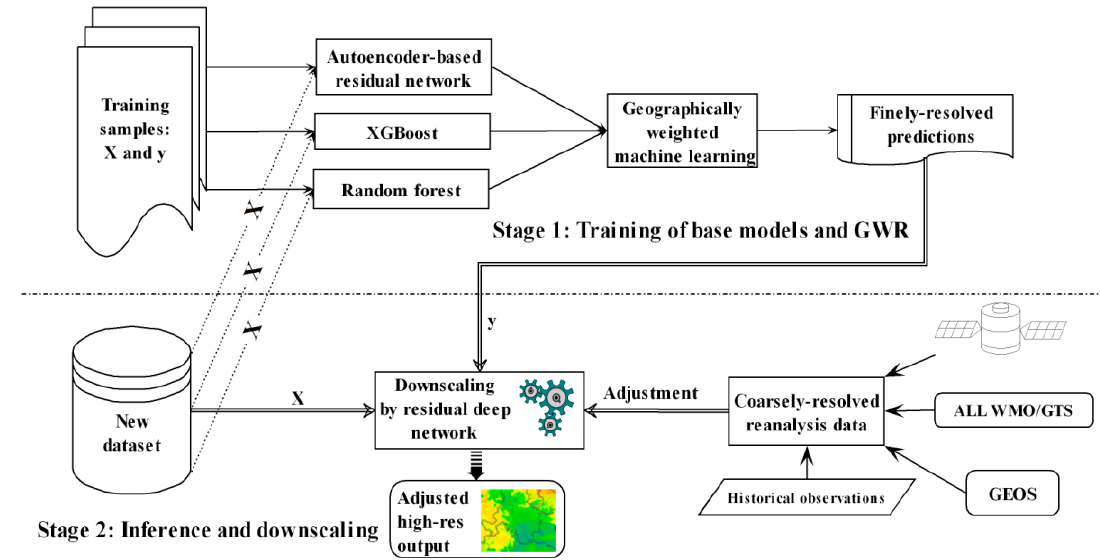
Figure 2. Systematic framework: training of base models and geographically weighted regression (GWR) (Stage 1) and inference and downscaling (Stage 2).